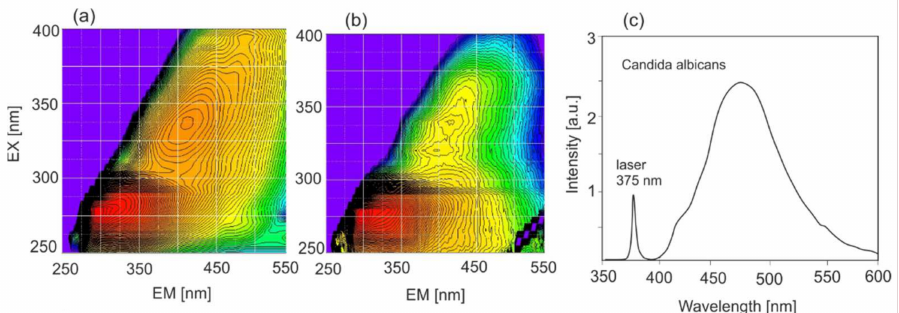
Figure 9. Spectral characteristics of selected fungi: ( a ) EM–EX map of Penicyllium chrysogenium , ( b ) EM–EX map of Aspergillus flavus , ( c ) LIF spectrum of Candida albicans .